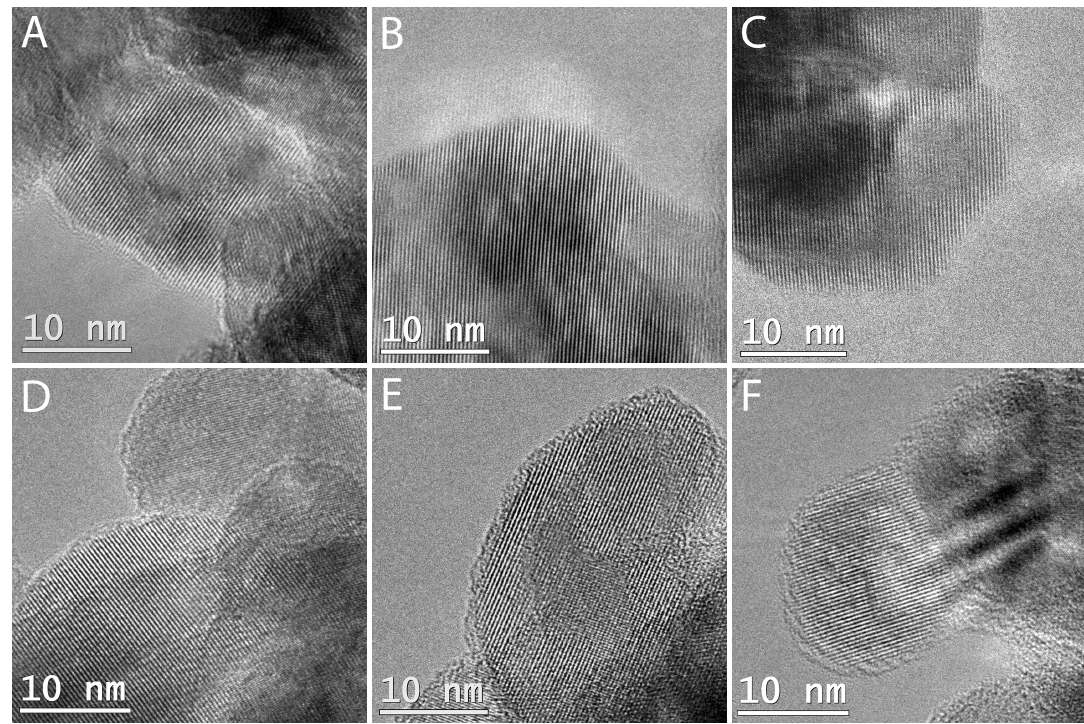
Figure 1. Typical transmission electron microscopy (TEM) images of samples ( A ) TS0, ( B ) TS1, ( C ) TS2, ( D ) TS3, ( E ) TS4, and ( F ) TS5. Table 1. Theoretical Si:Ti ratio, SiO 2 shell thicknesses measured by TEM and EDX, specific surface areas (SSA), t-plot external area and t-plot micropore area from